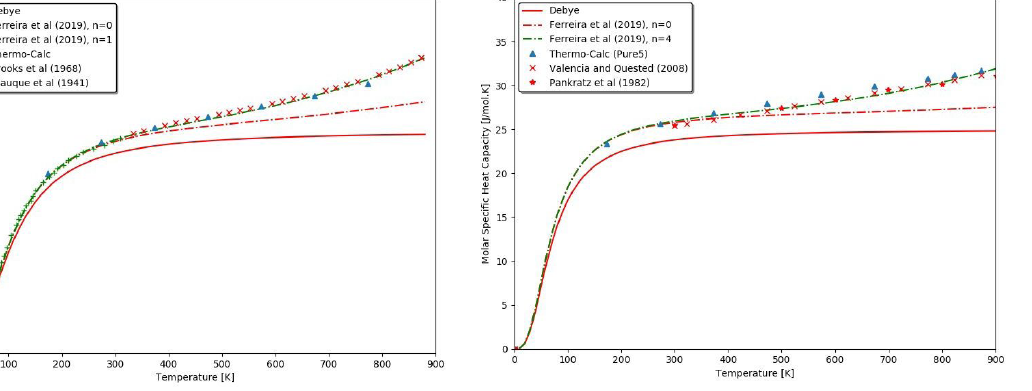
Figure 2. Comparison of the molar heat capacity of pure Al by applying Debye, Thermo-Calc, the present approach, and experimental results of Giauque and Meads 29 and Brooks and Bingham 30 .